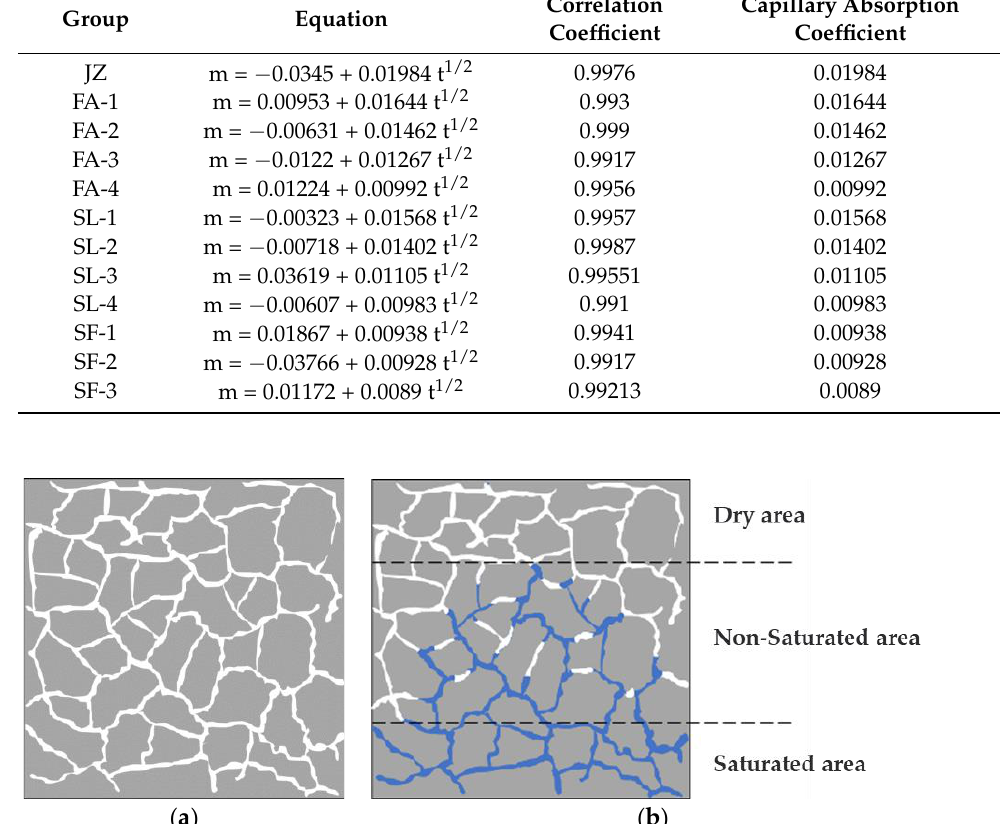
Table 4. Capillary water absorption coefficient fitting equation and parameters.